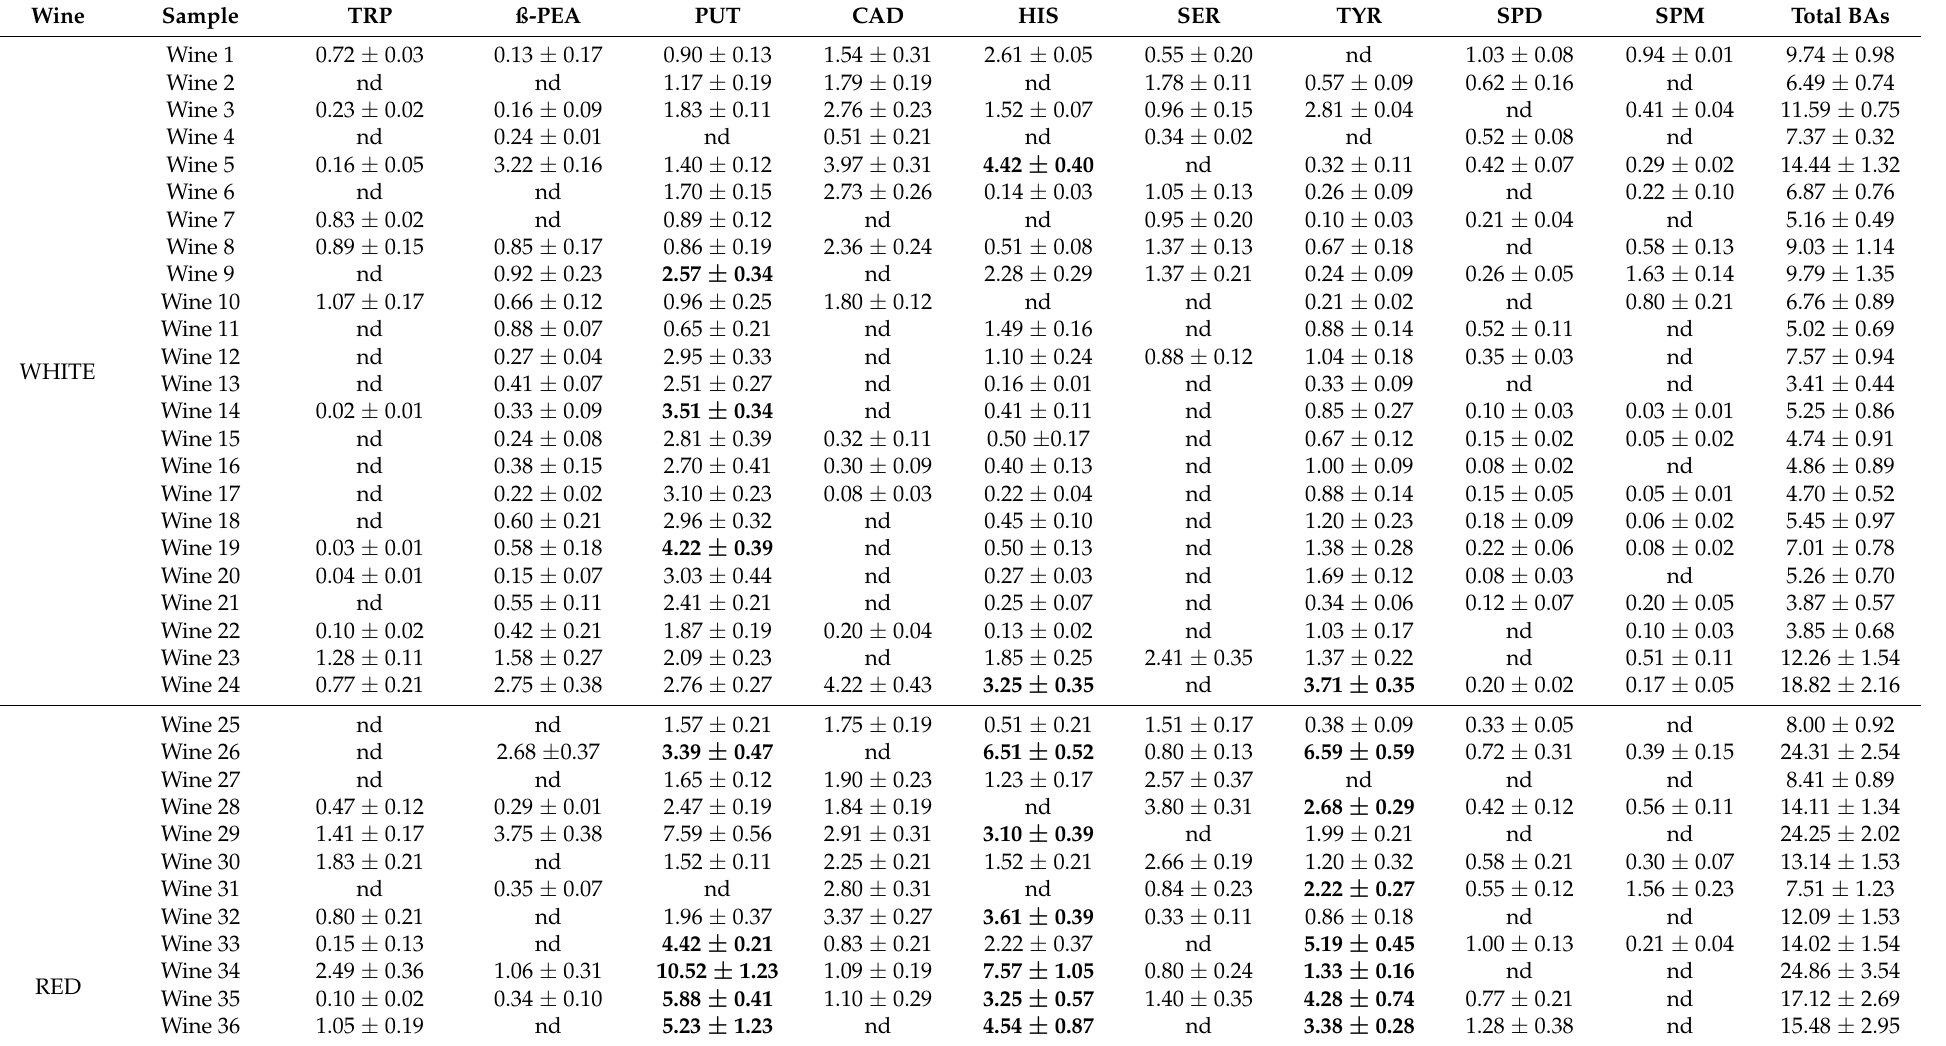
Table 4. Biogenic amines (mg L − 1 ) amount in white and red